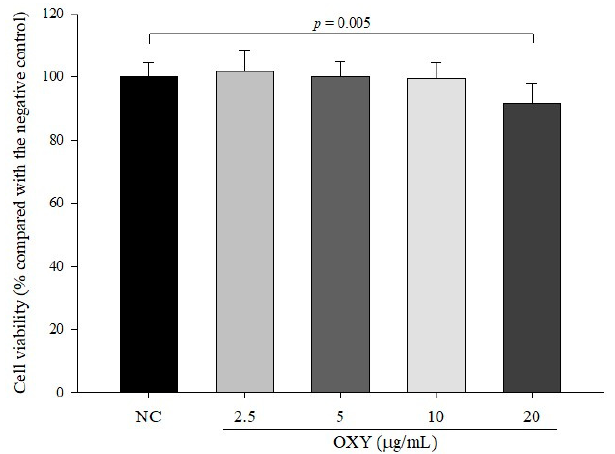
Figure 1. Cytotoxicity of oxyresveratrol (OXY) in LS 174T goblet cells. Cell viability was measured by MTT assays after 24 h of treatment with OXY. Data are indicated the mean ± SD of three independent experiments performed in